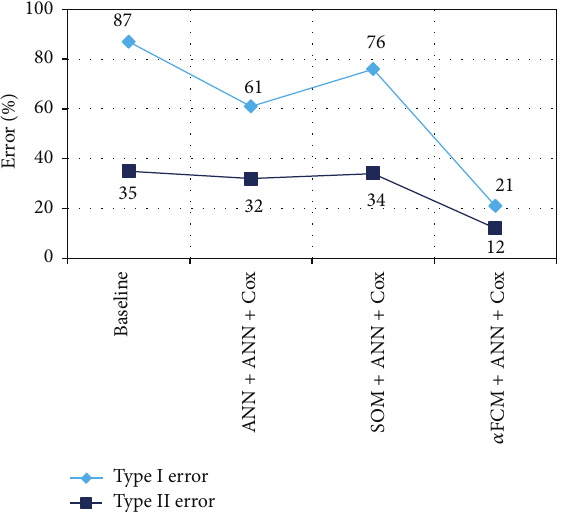
Figure 4: The Type I and II errors of hierarchical